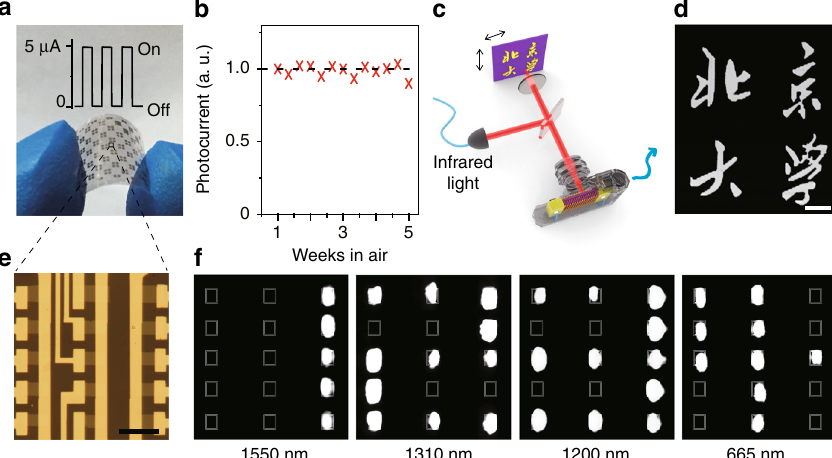
Fig. 4 2D fl exible Bi 2 O 2 Se photodetector arrays. a Photograph of 2D Bi 2 O 2 Se photodetectors and arrays on mica. Inset shows photoresponse of one typical photodetector when bending the substrate with strain up to 1%. The current show robust increase when illumination of 1200 nm with power of about 100 μ W is on. b 2D Bi 2 O 2 Se photodetector maintains stable photoresponse in air for at least 5 weeks. c Schematic of the single-pixel imaging process. The 2D Bi 2 O 2 Se photodetector quantify the infrared re fl ection of the sample structure by measuring corresponding photocurrent. When the structure is scanned, the detector records the magnitudes of re fl ection signals and process them into image. d Infrared images taken by single-pixel photodetector of 2D Bi 2 O 2 Se under excitation at λ = 1150 nm. Scale bar, 100 μ m. e Optical image of 3 × 5 multi-pixel array of 2D Bi 2 O 2 Se photodetectors. Scale bar, 10 μ m. f The array ’ s photocurrent mappings are achieved by recording the photocurrents while scanning the array over a pre-focused laser beam with spot size of 1 to 2 μ m. By deliberately choosing several channels in a parallel regime, photocurrents from the chosen pixels are recorded and shown in the photocurrent mapping. Here, the resulting photocurrent images with shape of 1, 2, 3, and 4 are taken under illumination of 1550 nm, 1310 nm, 1200 nm, and 665 nm light,